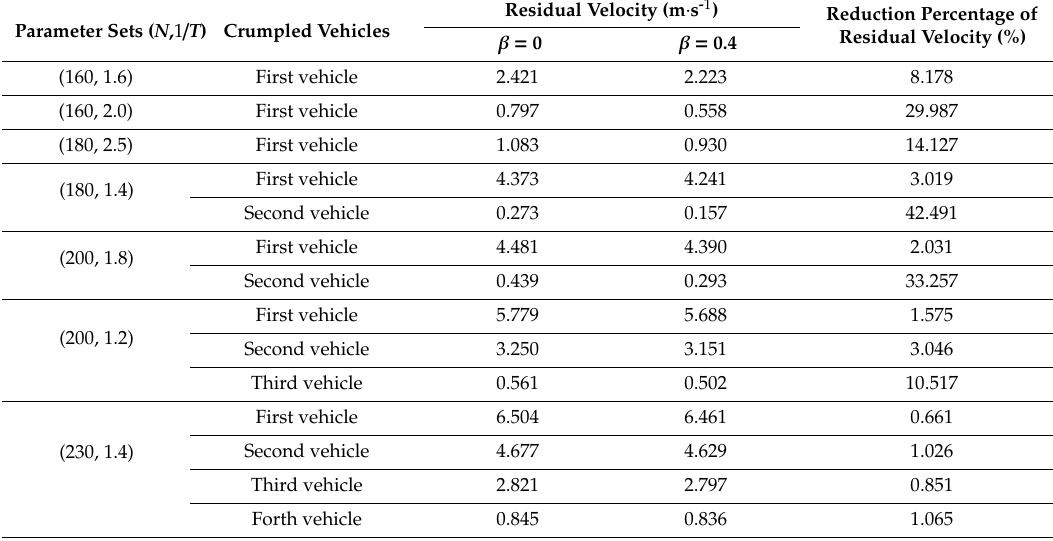
Table 1. The residual velocities of crumpled vehicles when the collisions occur. Parameter Sets ( N , 1 / T ) Crumpled Vehicles